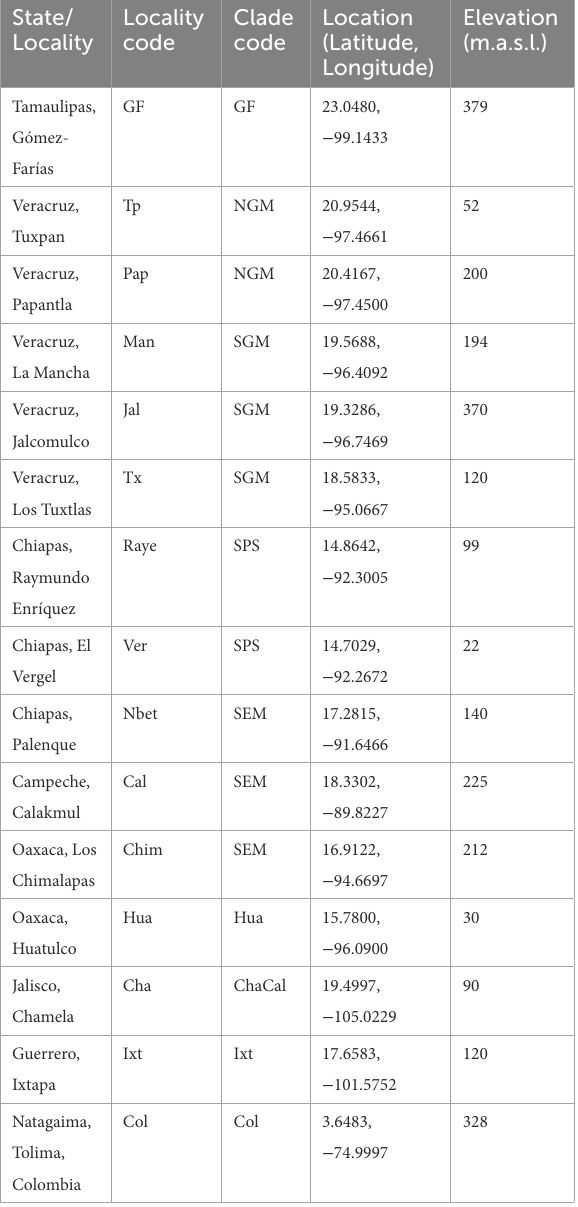
TABLE 1 Localities of Canthon cyanellus from Mexico and